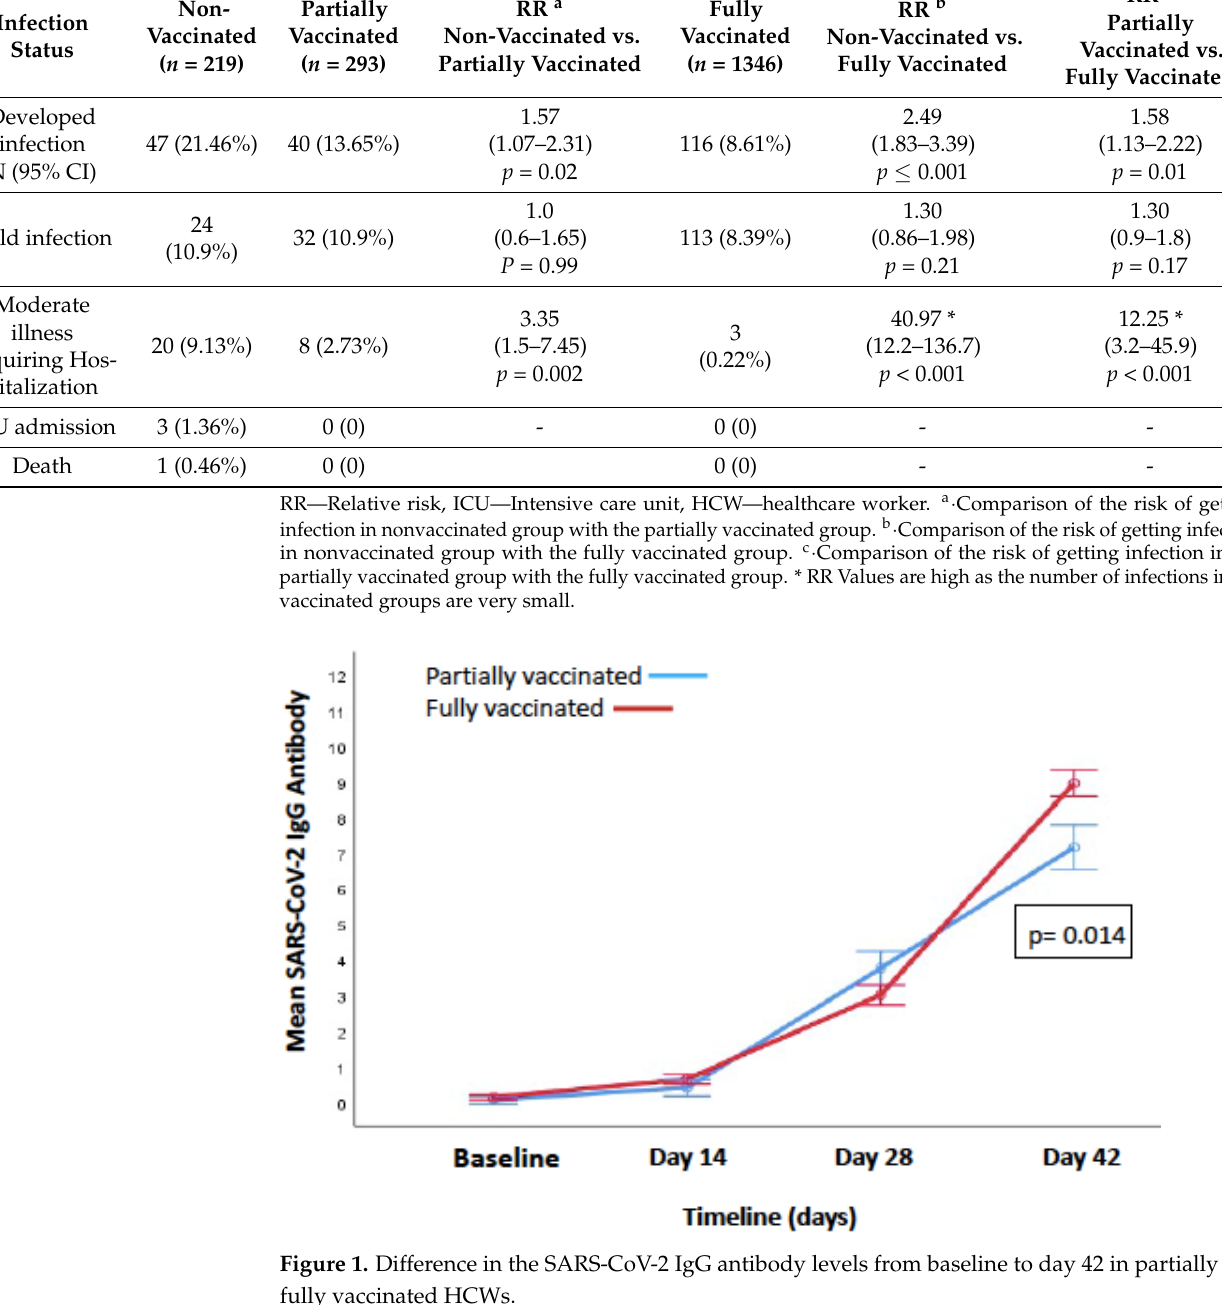
Table 2. Clinical presentation of VBT infections in HCWs and association with vaccination.